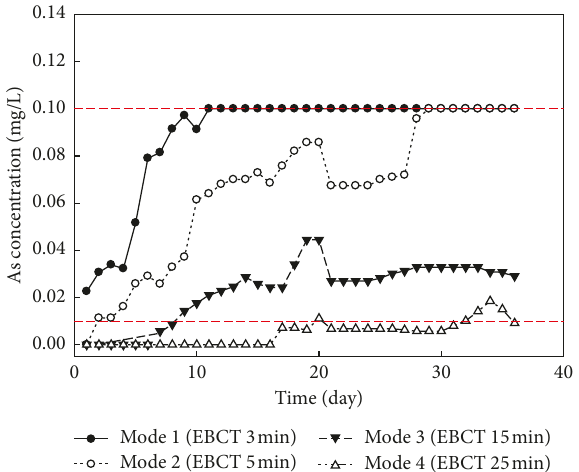
Figure 8: Effects of iron-based adsorbents on other ions and THF on the As adsorption reaction (Fe.G.A: iron- (Fe-) based granular adsorbents; S: synthetic wastewater; N: natural wastewater; initial As concentration: 0.2 mg/L; quantity of adsorbents: